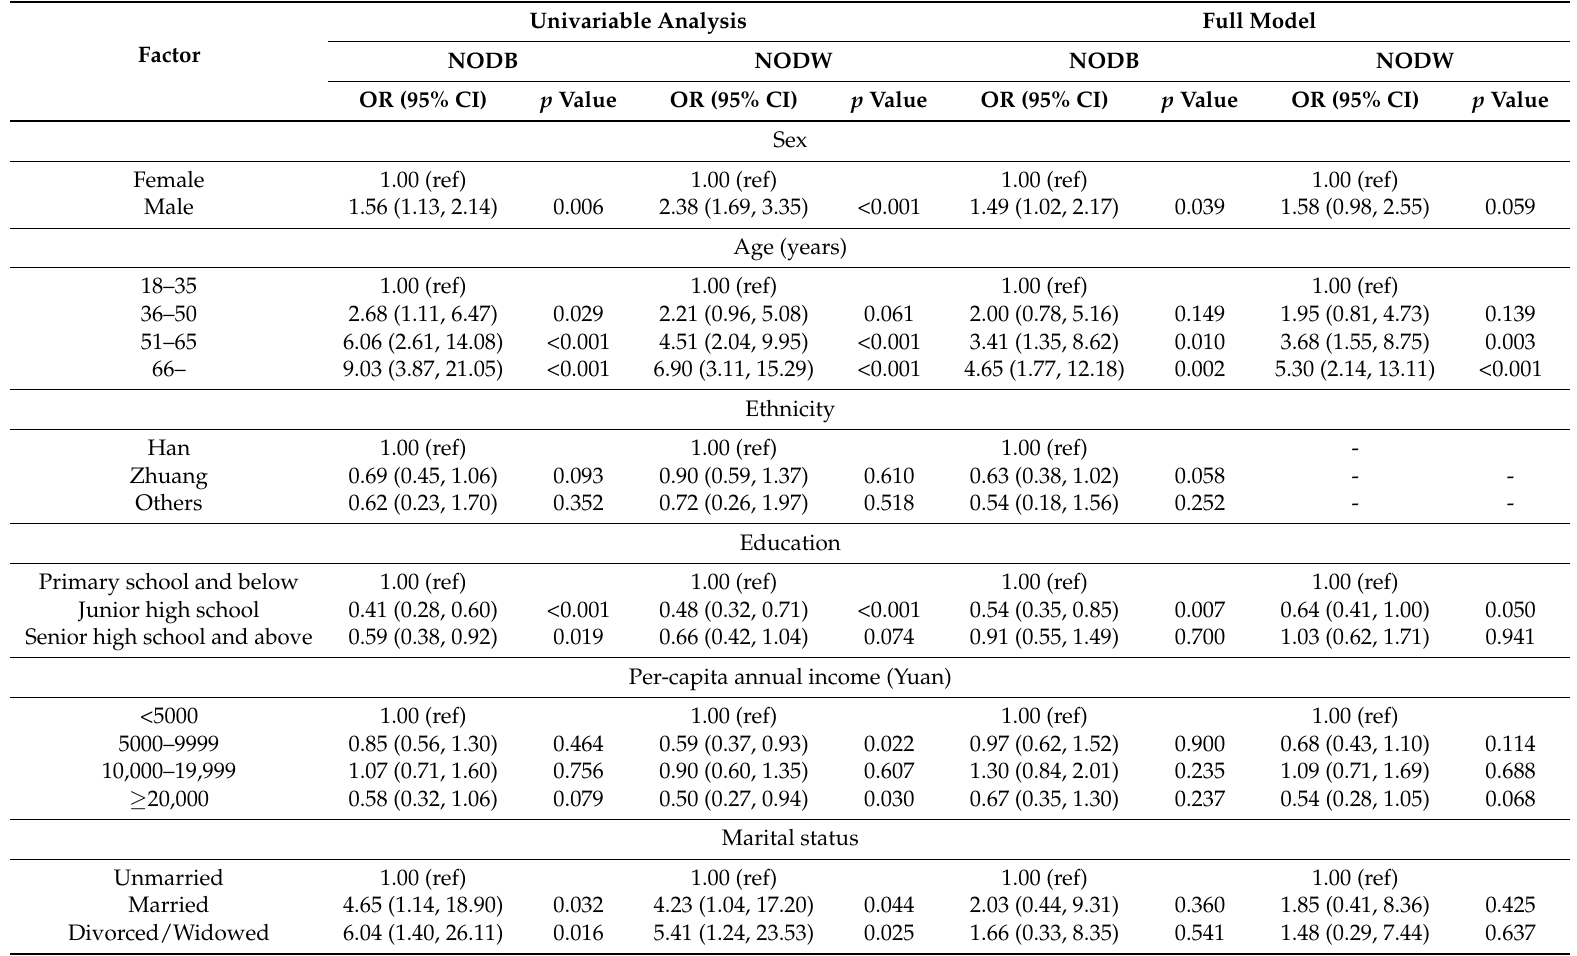
Table 2. Associated factors for non-obese diabetes in